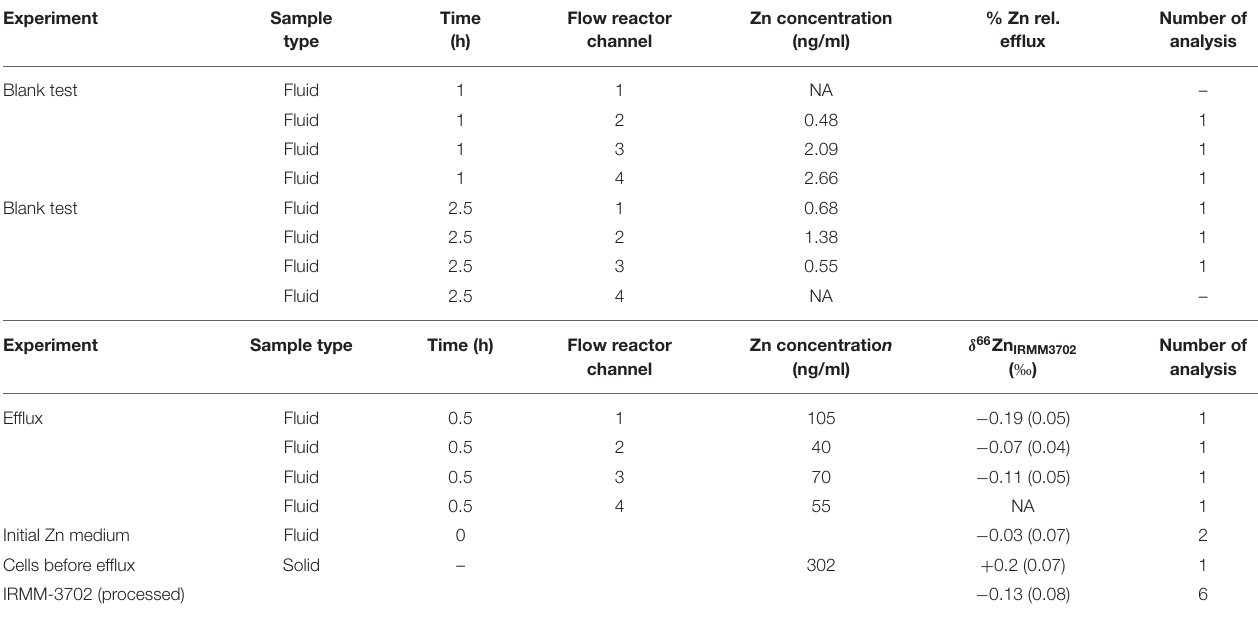
TABLE 2 | Data summary for uptake-efflux